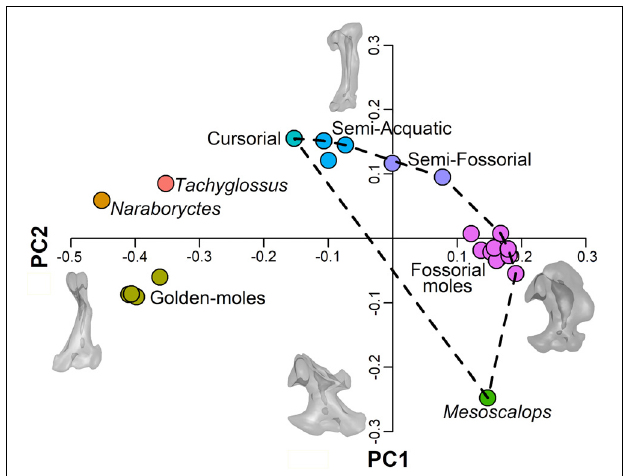
FIGURE 2 | Scatterplot of the first 2 PC scores. Convex hull indicates the Talpidae. Talpidae are colored according to their lifestyle. Other taxa are colored according to their specific status. Meshes are deformed according to PC axes